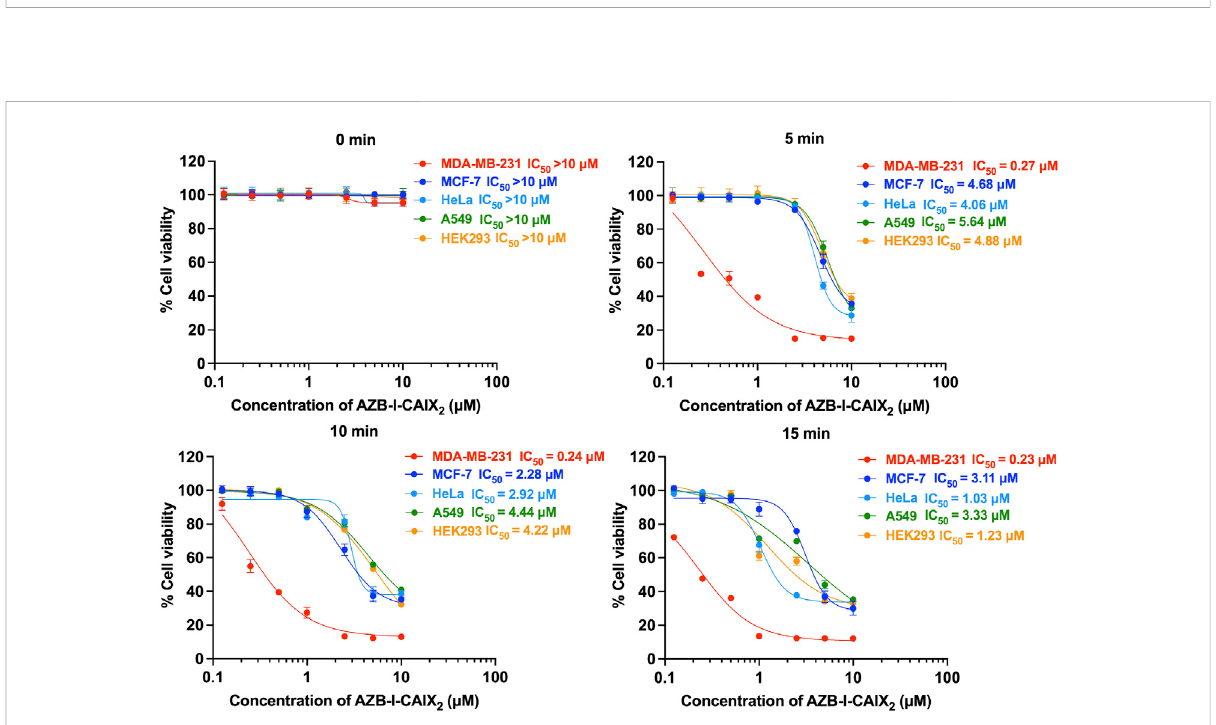
Half maximal inhibitory concentration (IC 50 ) curves of AZB-I-CAIX 2 tested on CAIX+ (MDA-MB-231) and CAIX- (MCF-7, HeLa, A549, HEK293) cells under various light exposure times (0 min, 5 min, 10 min, 15 min). The cells were incubated with various concentrations of AZB-I-CAIX 2 (0 – 10 μ M) for 6 h and irradiated with a lamp (660 nm, power density of 8.7 mW cm − 2 ). IC 50 was evaluated using GraphPad Prism9